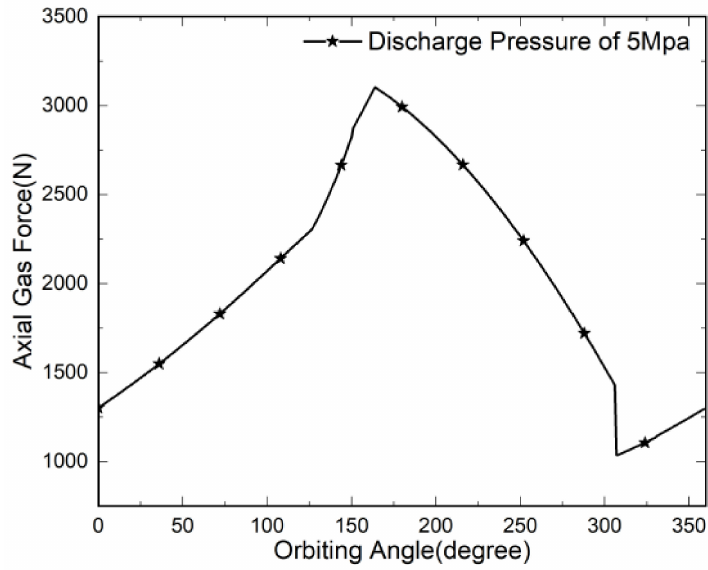
Figure 2. Relationship between axial force and rotation